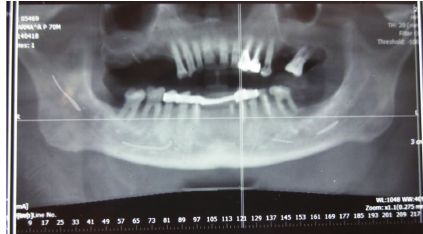
Figure 2: CBCT panorama view reveals heterogeneous soft tissue mass in left retromolar region.